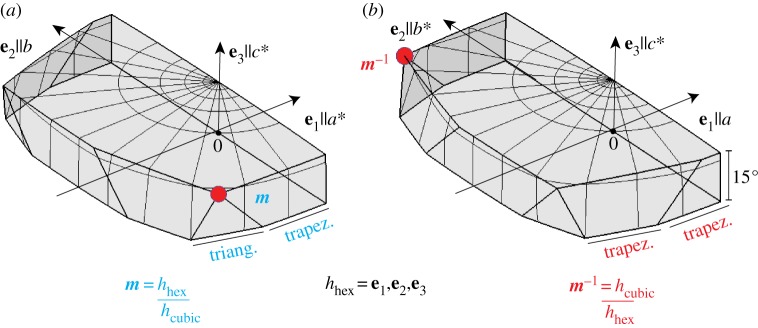
Influence of the sequence on the fundamental zone: Either (a) cubic–hexagonal misorientations (e1–e3 refer to cubic reference frame) or (b) hexagonal-cubic misorientations (e1–e3 refer to hexagonal reference frame) are formed. Note the change in geometry in (b) compared to (a) and the changed location of the Blackburn relation. Both FZ were formed with the standard definition for hexagonal symmetry as was done previously in figure 15a.